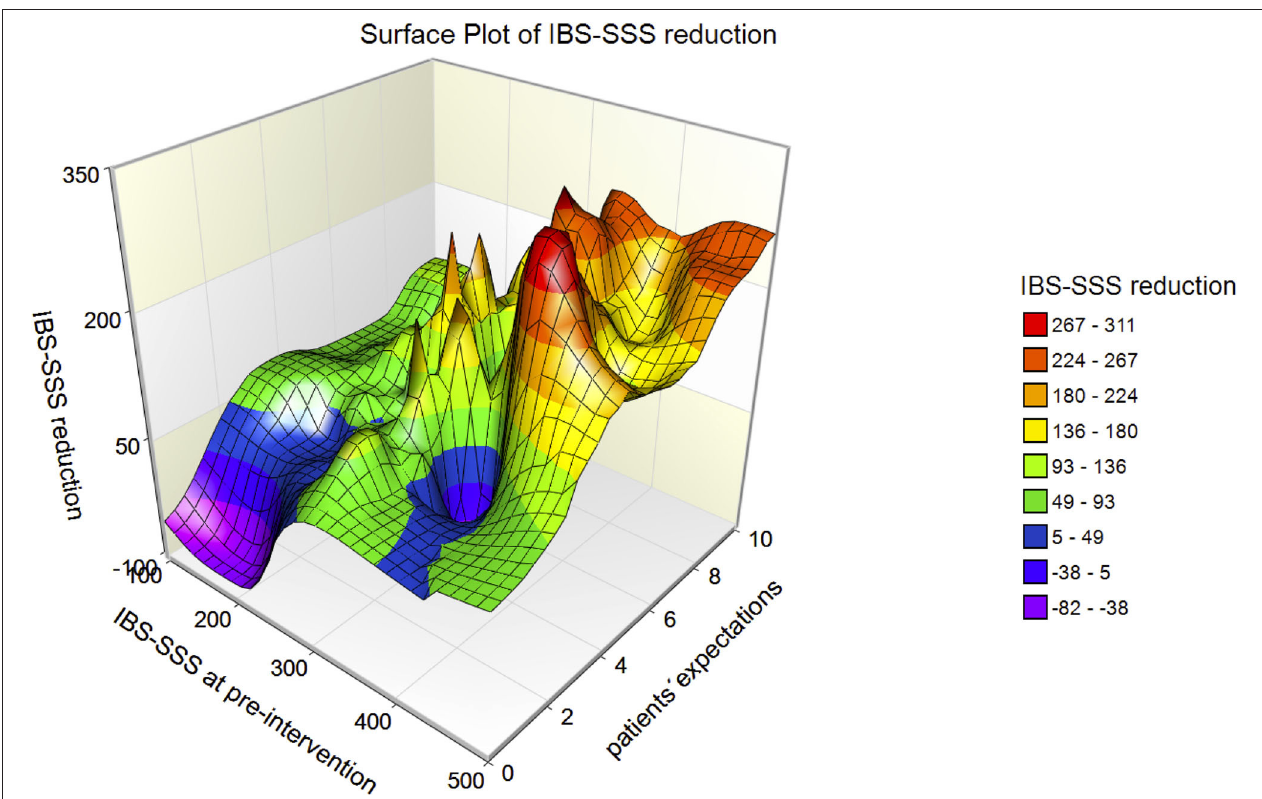
TABLE 3 | Crosstabulation of IBS severity classes by IBS severity classes after 3 months. IBS-SSS at